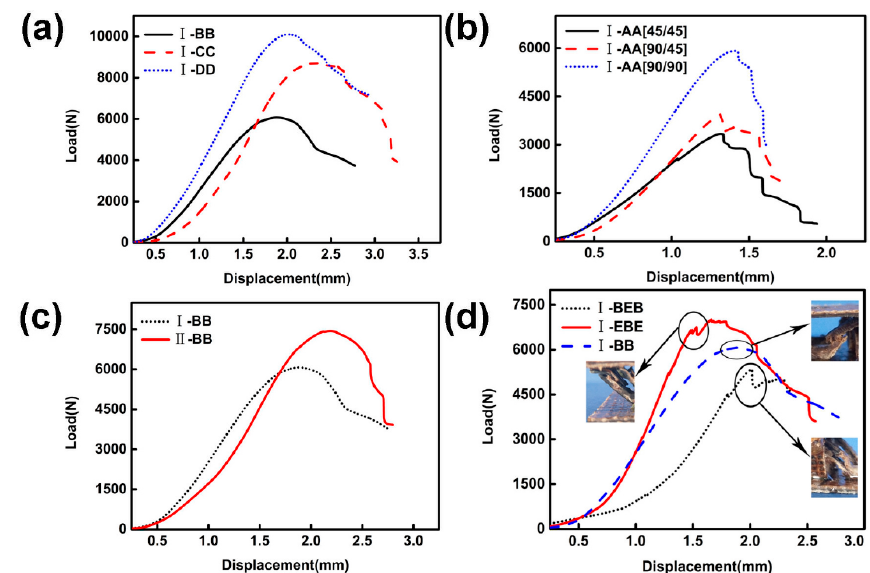
Figure 8. Displacement–load curve for ( a ) different types of jute cloth, ( b ) different fiber angles, ( c ) different configurations, ( d ) different material configurations.